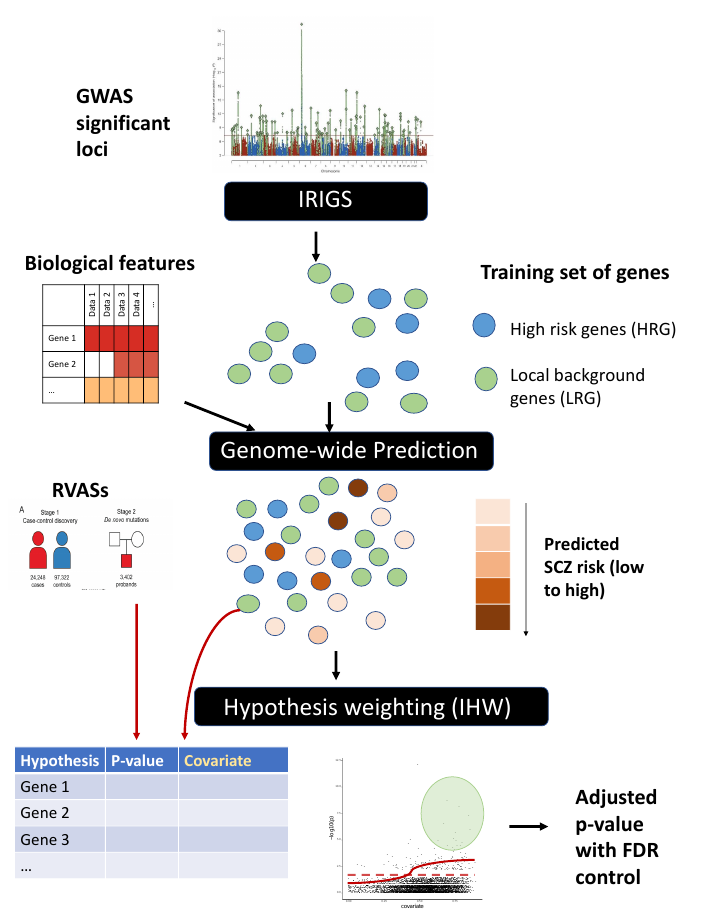
Figure 1. Overview of the workflow. Our approach involves three stages. First, we obtained HRGs and LRGs predicted by iRIGS as positive and negative instances for subsequent training; second, we used the positive and negative training sets and the selected gene-level biological annotations as features to train a Random Forest model, and used the model to generate predictive scores for all known protein-coding genes in the genome; third, we used the prediction score as the informative covariate for each gene, and used IHW to improve gene discovery from